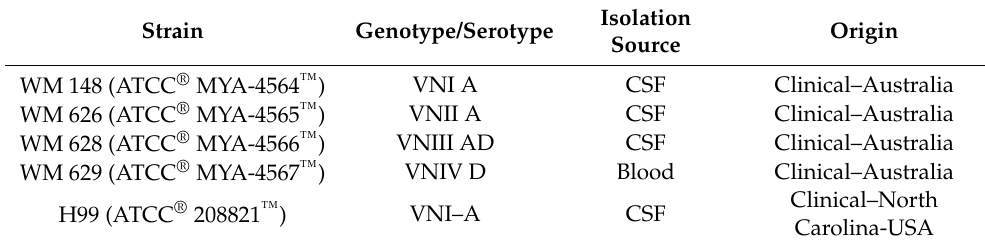
Table 1. C. neoformans strains used in this study (American Type Culture Collection).